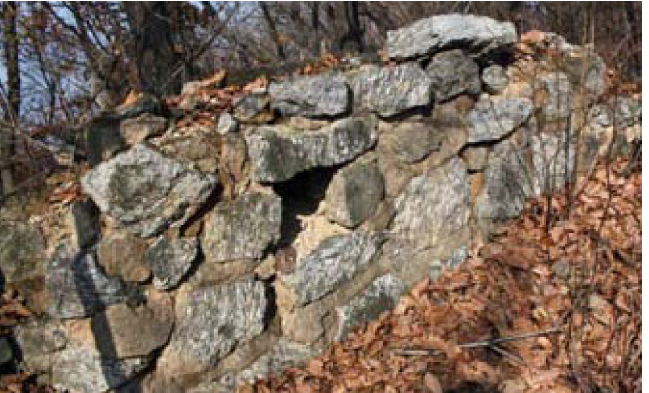
Figure 8. Natural stone crenellations in Bongamseong. Reprinted with permission from Ref. [44]. 2014, National Research Institute of Cultural Heritage.